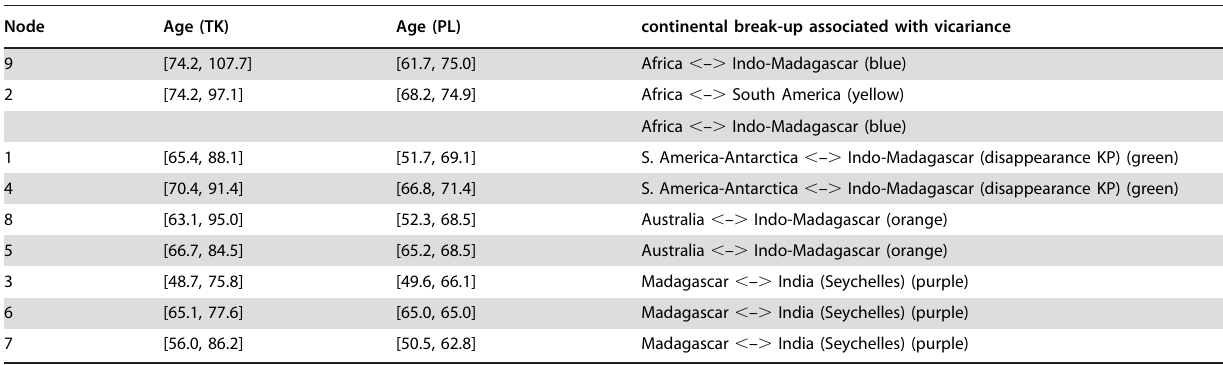
Table 2. Dating estimates (mya) for vicariance events in the early evolution of Microhylidae and Natatanura. .. ... .... ... ... .... ... ... .... ... ... .... ... ... .... ... ... .... ... ... .... ... ... .... ... ... .... ... ... .... ... ... .... ... ... .... ... ... .... ... ... .... ... ... .